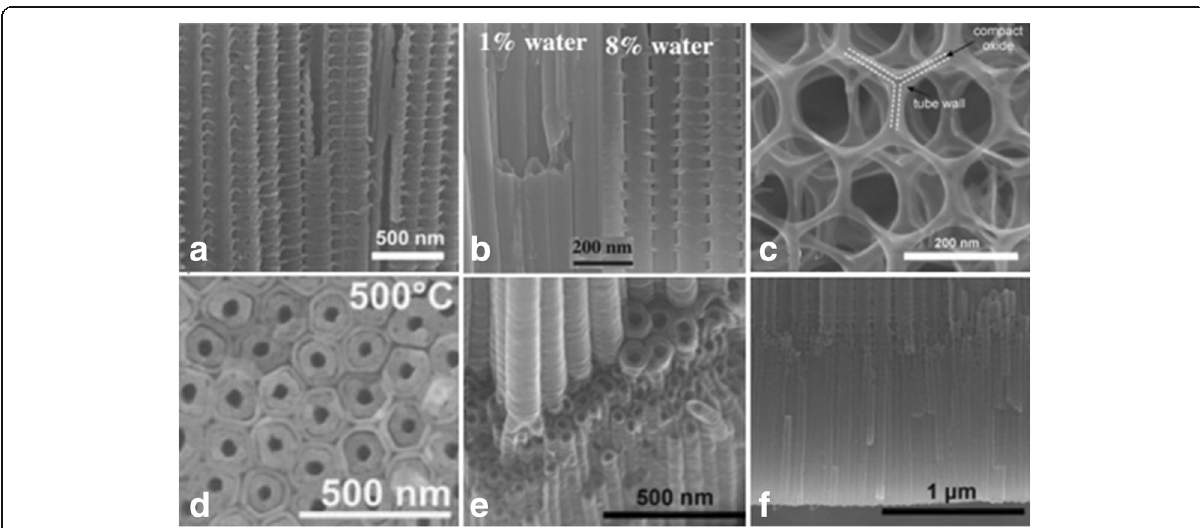
Fig. 4 SEM images of advanced TiO 2 nanotube morphologies. a Bamboo-type reinforced TiO 2 nanotubes are fabricated under specific alternating-voltage (AV) conditions in ethylene glycol consisting of 0.2 mol/L HF, with a sequence of 1 min at 120 V and 5 min at 40 V. Reproduced from ref. [38]. b Transition from smooth to bamboo-like TiO 2 nanotubes can be induced by anodization with controlled water addition (water contents:1 to 8%) to a 0.135 M NH 4 F/ ethylene glycol electrolytereproduced from ref. [39]. c The 2D nanolace structures are obtained under voltage cycling carried out for an extended period of time in the fluoride containing electrolyte, with a sequence of 50 s at 120 V and 600 s at 0 V. Reproduced from ref. [38]. d The double-walled TiO 2 nanotubes are grown by anodization of Ti in a fluoride containing ethylene glycol electrolyte at 120 V after annealing at 500 °C with a heating rate of 1 ° C s − 1 . Reproduced from ref. [40]. e The branched nanotubes can be observed by voltage stepping, first at 120 V (6 h) and then at 40 V (2 h). Reproduced from ref. [38]. f The double-layer nanotubes with equal or two different tube diameters can be seen. Reproduced from ref.